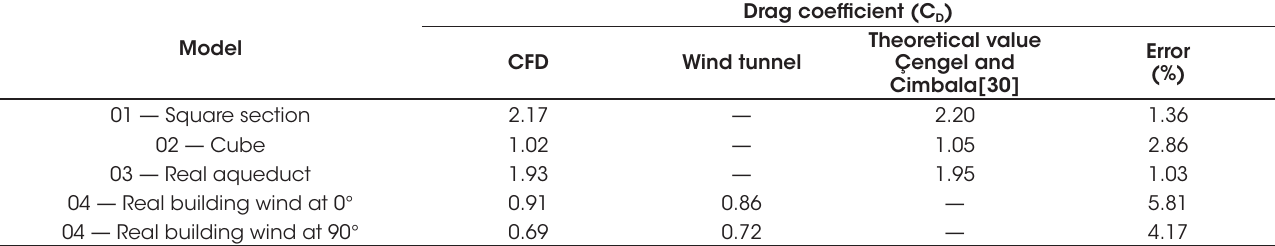
Summary of simulations - 2D and 3D flow Model